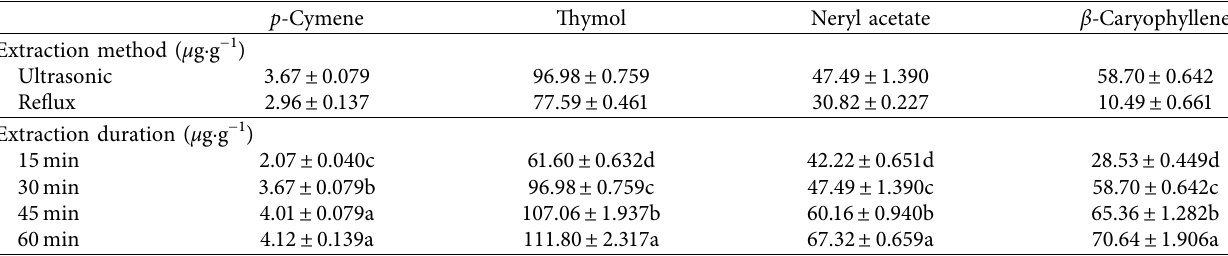
Table 3: Investigation of extraction